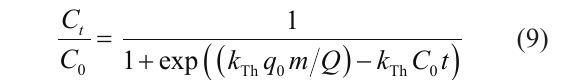
Table 4 – BDST model parameters for acrylic acid adsorp- tion onto CaO